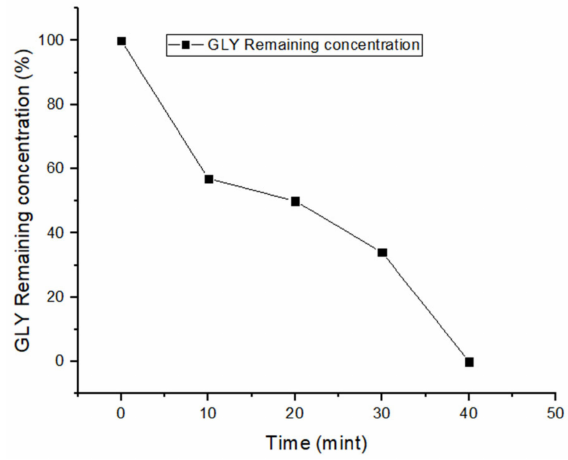
Figure 4. Kinetics of GLY removal from tap water at pH